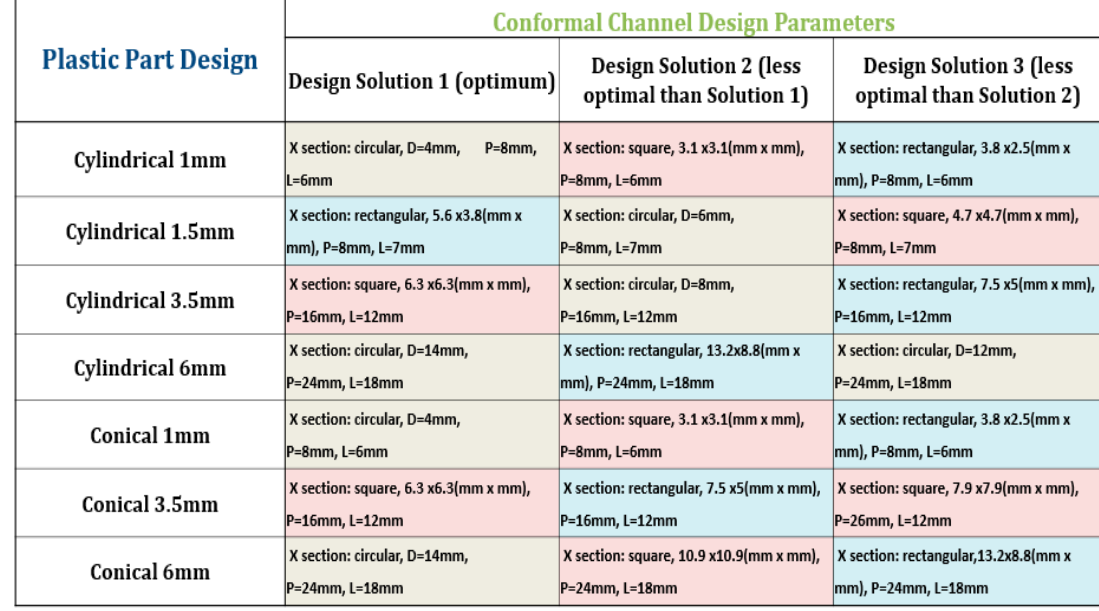
Figure 11. Conformal cooling channel design guidelines.